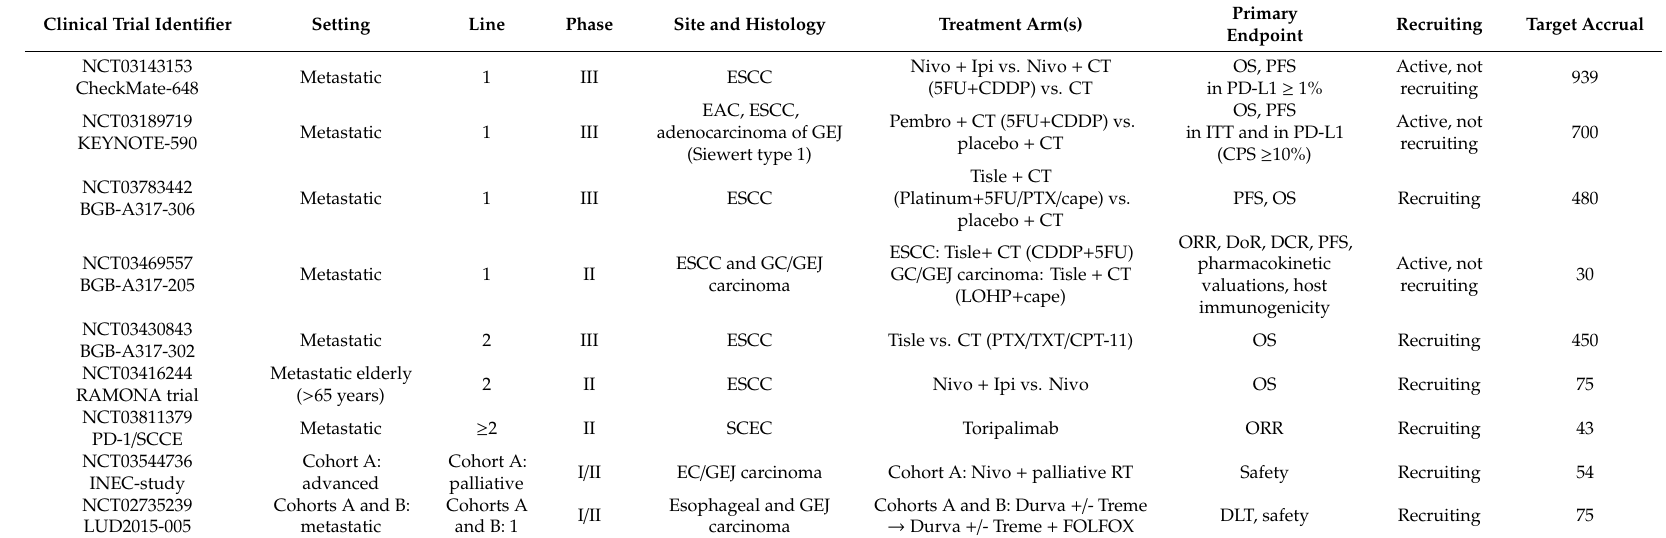
Table 2. Selected ongoing trials in metastatic esophageal